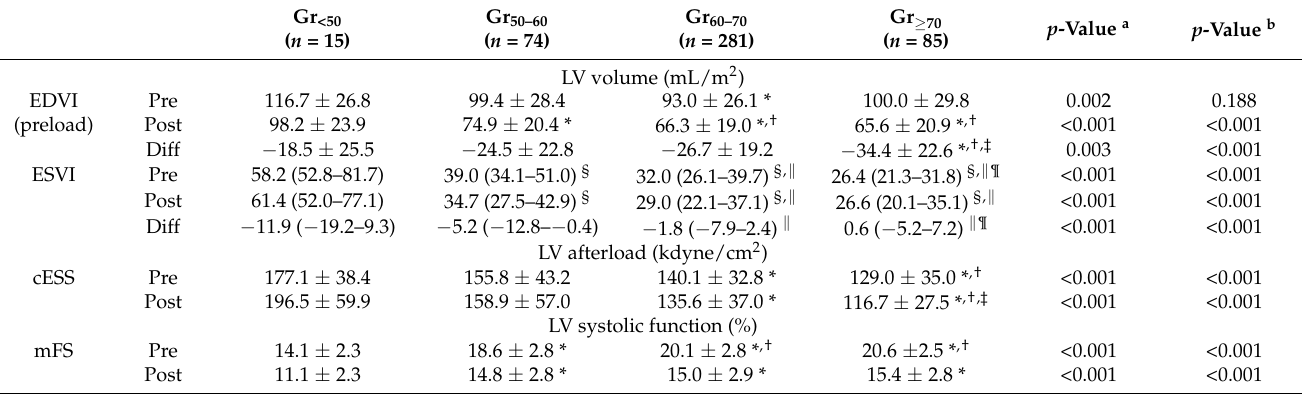
Table 2. LV volume, afterload, and systolic